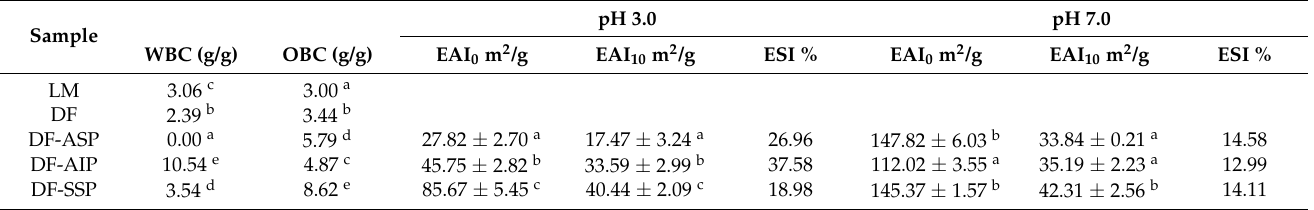
Figure 5. ( A – D ) Effect of adsorption time on the interfacial tension of DF- Α SP ( ■ ) DF- Α IP ( ♦ ), and DF-SSP ( ▲ ) at different protein concentrations. Different letters indicate significant ( p < 0.05) differences between means. Notations as in Table 1. Table 2. Water/oil binding capacity and emulsifying activity and stability of the protein